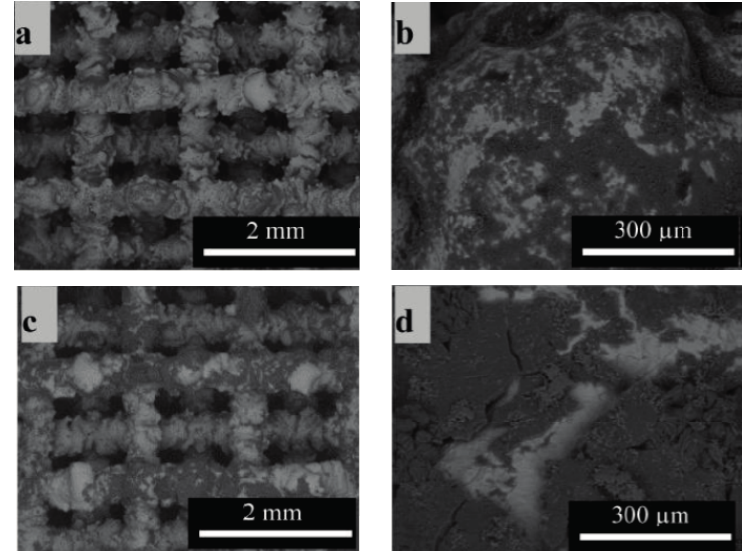
Figure 3. Scanning electron microscopy images of TiAl6V4 scaffolds with chitosan-BG composite coating containing ( a ) and ( b ) micro BG; and ( c ) and ( d ) nano BG